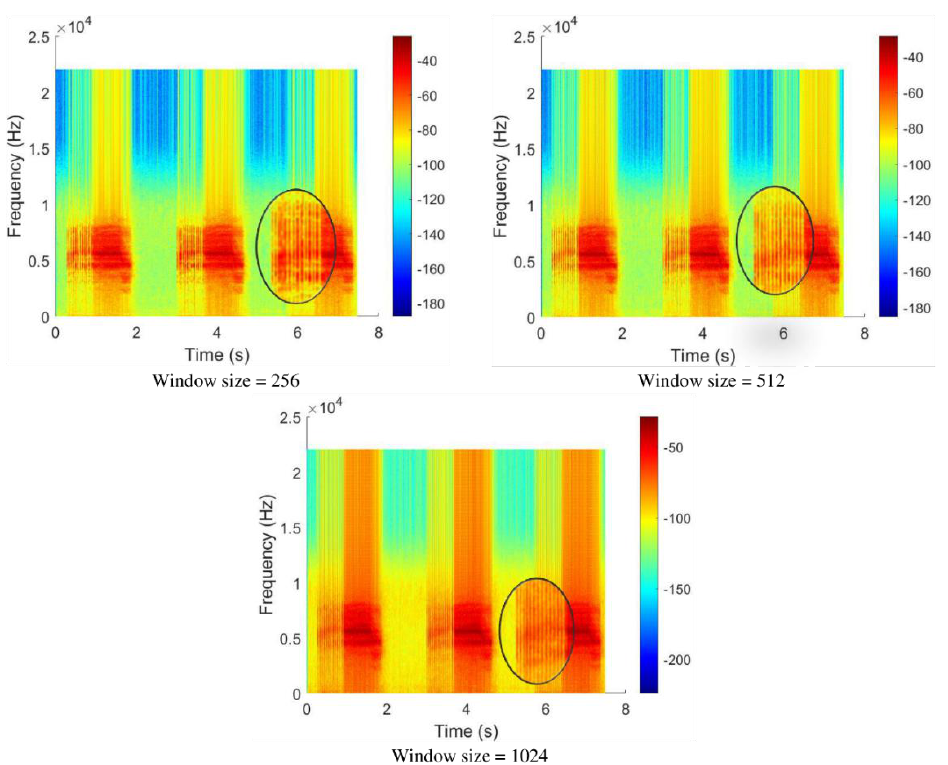
Figure 10. Spectrograms generated with different window